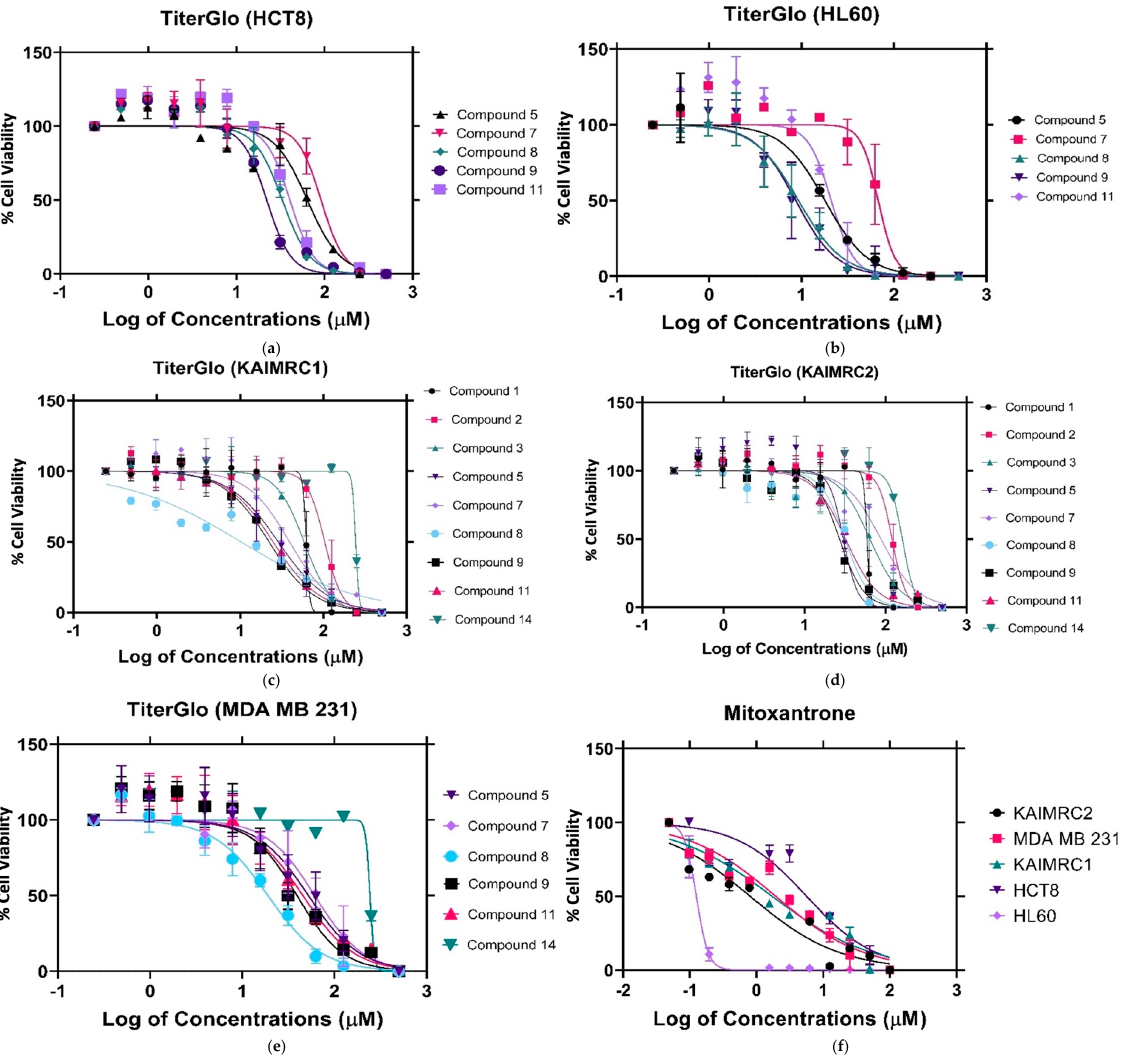
Figure 4. CellTiter − Glo assay against the following cell lines: ( a ) CellTiter − Glo assay against HCT8 cancer cell lines., ( b ) CellTiter − Glo assay against HL60 cancer cell lines., ( c ) CellTiter − Glo Figure 4. CellTiter-Glo assay against the following cell lines: ( a ) CellTiter-Glo assay against HCT8 assay against KAIMRC1 cancer cell lines, ( d ) CellTiter − Glo assay against KAIMRC2 cancer cell lines , ( e ) CellTiter − Glo assay against MDA MB 231 cancer cell lines, and ( f ) CellTiter − Glo assay of mitoxantrone positive control. cancer cell lines., ( b ) CellTiter-Glo assay against HL60 cancer cell lines., ( c ) CellTiter-Glo assay against KAIMRC1 cancer cell lines, ( d ) CellTiter-Glo assay against KAIMRC2 cancer cell lines, ( e ) CellTiter-Glo assay against MDA MB 231 cancer cell lines, and ( f ) CellTiter-Glo assay of mitoxantrone positive